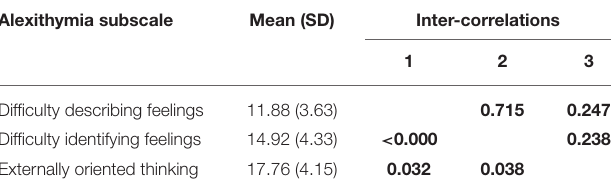
TABLE 1 | Descriptive statistics and inter-correlations of alexithymia subscale scores.